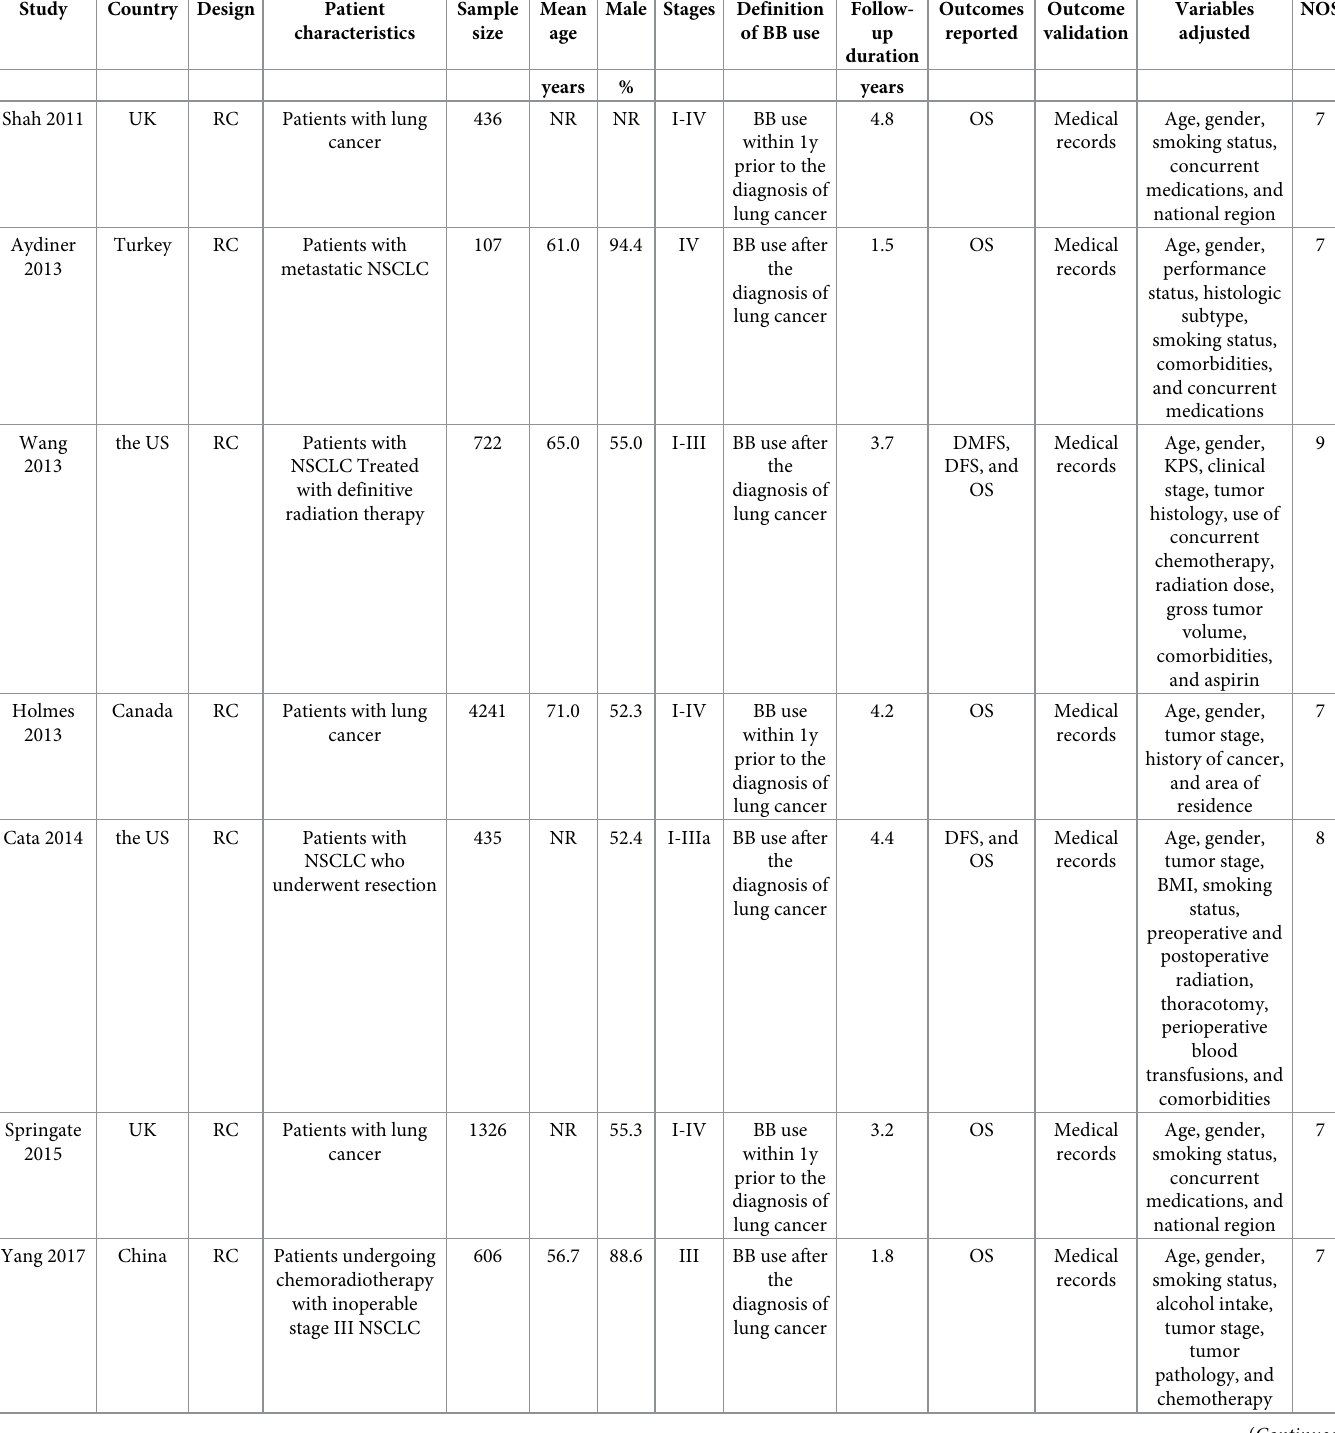
Table 1. Characteristics of the included